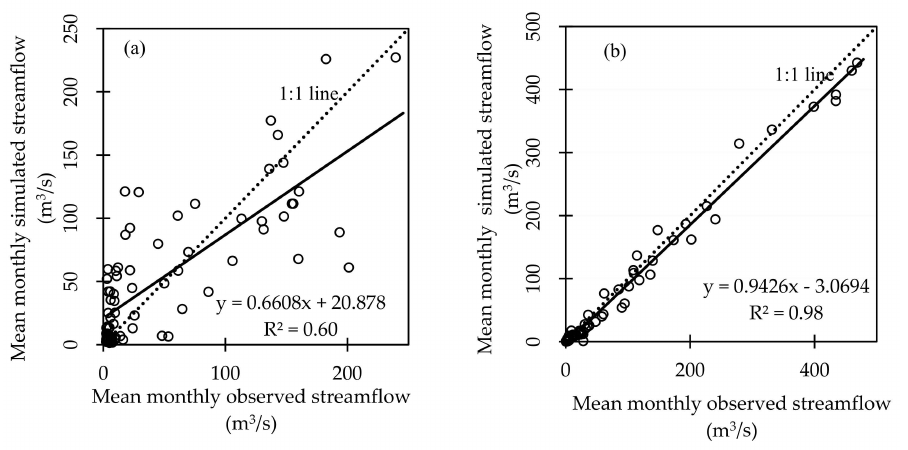
Figure 8. Correlation of mean monthly observed streamflow during ( a ) calibration and ( b ) validation.